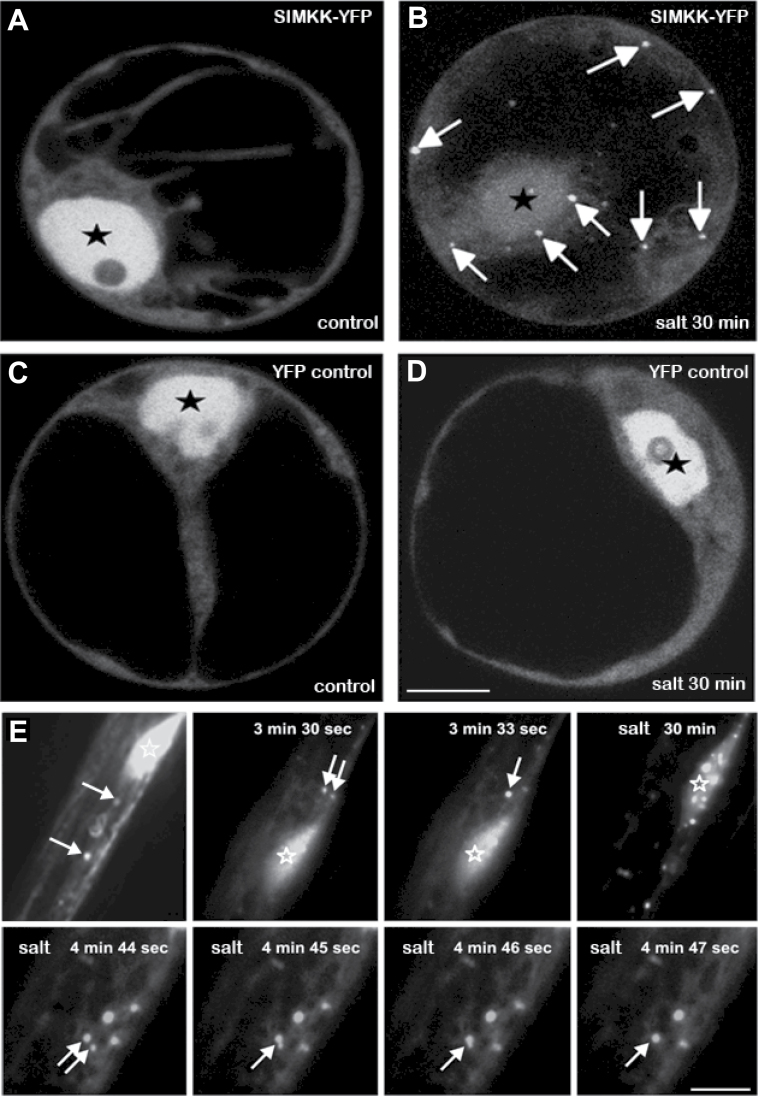

In vivo localization of YFP-tagged SIMKK in transiently transformed Arabidopsis protoplasts and in M. sativa roots. (A) SIMKK–YFP was located predominantly in the nucleus, but lower levels could also be detected in the cytoplasm of control protoplasts. (B) SIMKK–YFP relocates to cytoplasmic punctate compartments (indicated by arrows) in protoplasts treated with 250mM salt for 30min. (C, D) No relocation could be observed in salt-treated protoplasts transformed with control non-fused YFP. (E) In elongating epidermal root cell of M. sativa, SIMKK–YFP was located predominantly in the nucleus and partly in cytoplasmic motile compartments. Additional salt stress (250mM NaCl for 30min) caused accumulation of SIMKK–YFP in patches localized around nucleus. Arrows indicate some fast-moving and sometimes fusing cytoplasmic vesicular organelles with associated SIMKK–YFP. Figures represent individual frames (with indicated time points) from Supplementary Video S1 available at JXB online. Stars indicate nuclei. Bar, 7 μm (A–D); 10 μm (E).